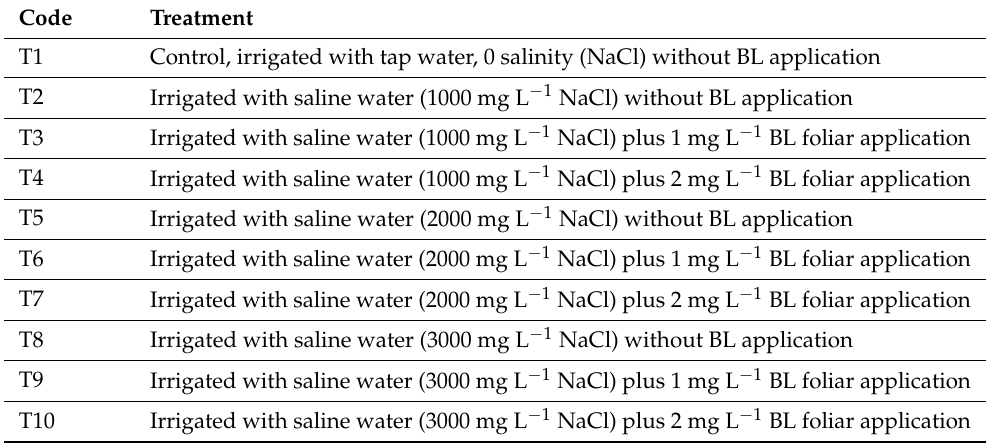
Table 1. Experimental treatments and their